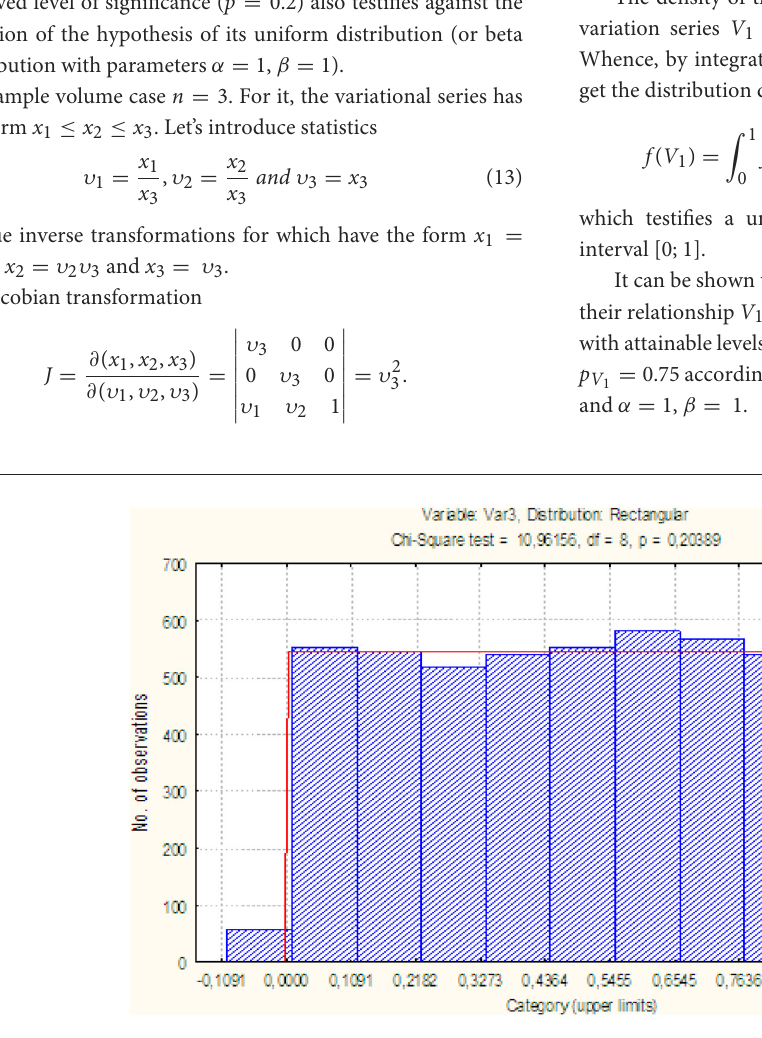
FIGURE5 Histogram of statistics distribution υ 1